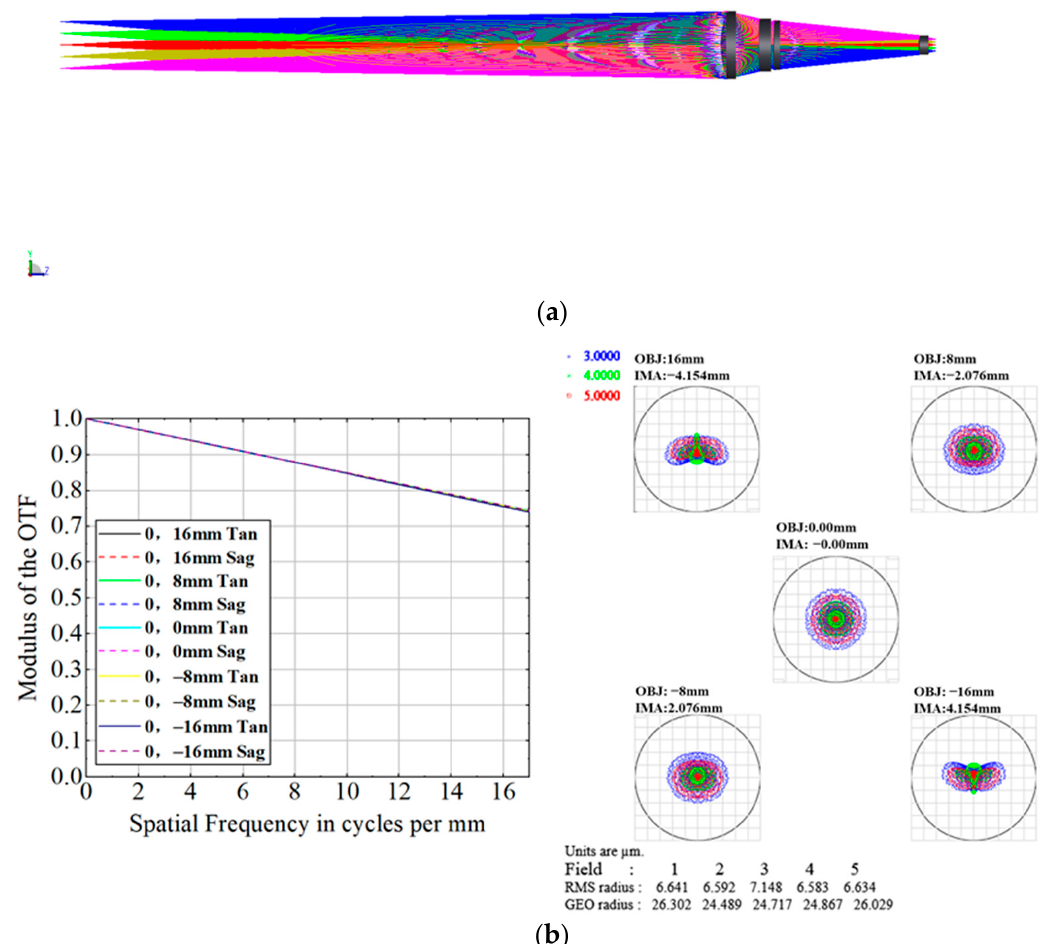
Figure 9. NIS design results: ( a ) NIS layout; ( b ) MTF and full field spot diagram for NIS. The paraxial magnification optimized NIS is β NIS = − 0.259, the image space NA of NIS is NA NISI = 0.190 and the exit pupil distance is EXPP NIS = 1 × 10 4 mm, all of which meet the design index.